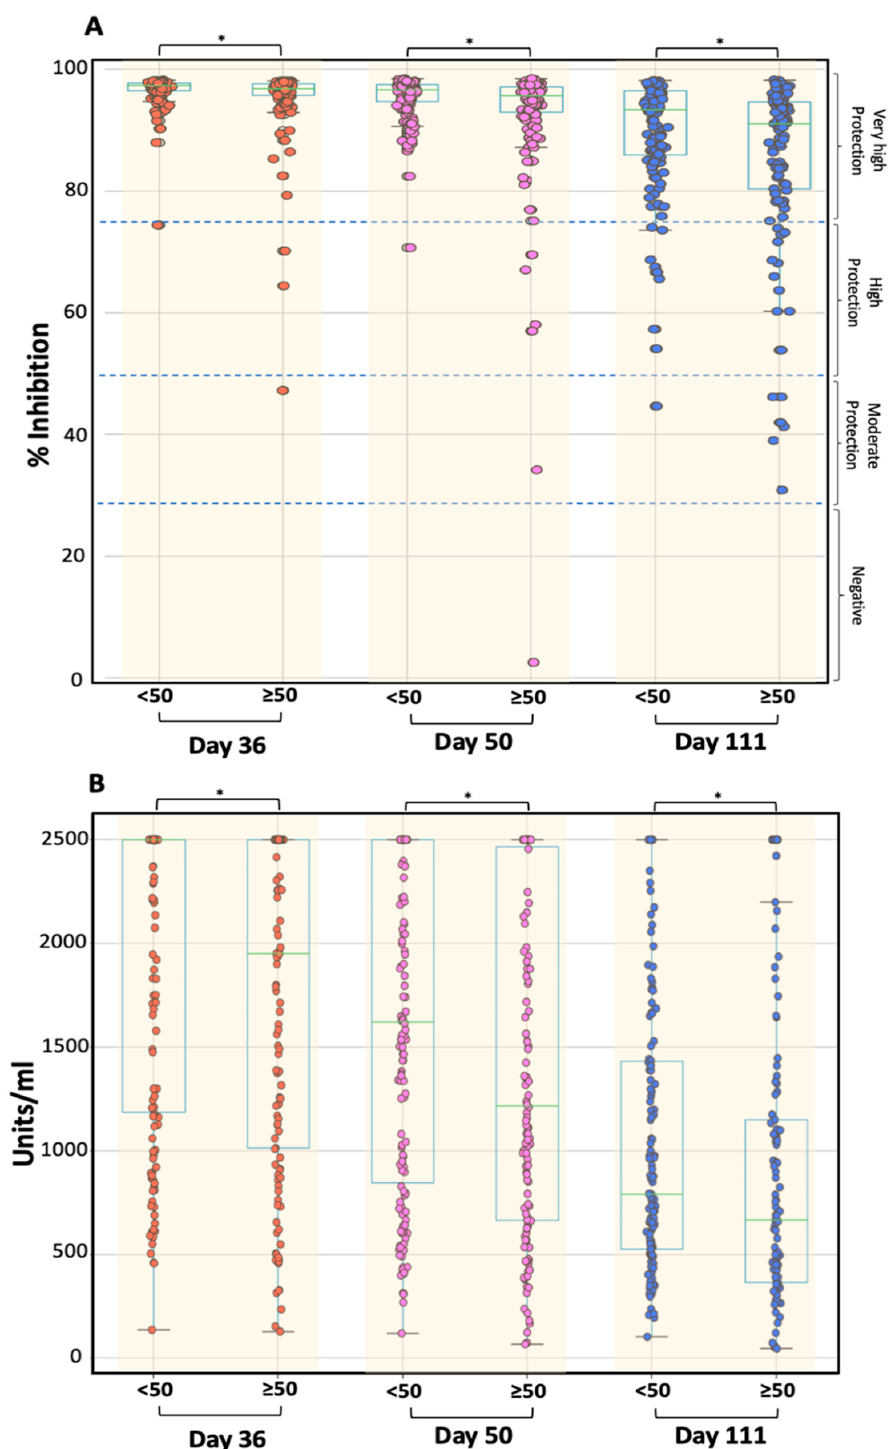
Figure 4. Inhibition (%) of SARS-CoV-2 binding to the human host receptor angiotensin-converting enzyme-2 for the two age groups: <50 years and ≥ 50 years. Neutralizing antibodies ( A ) and anti-S-RBDs ( B ) levels are shown for days 36, 50, and 111 (3 months after the second shot). Asterisks (*) indicate statistically significant differences ( p -value < 0.05) between the two compared groups (age < 50 vs. age ≥ 50) at each time point. The boxplot borders refer to the quartiles of the distribution, while the overlaid dots represent the individual values of antibody inhibition. Dashed lines refer to the borderline levels of inhibition i.e., 30%, 50%, and